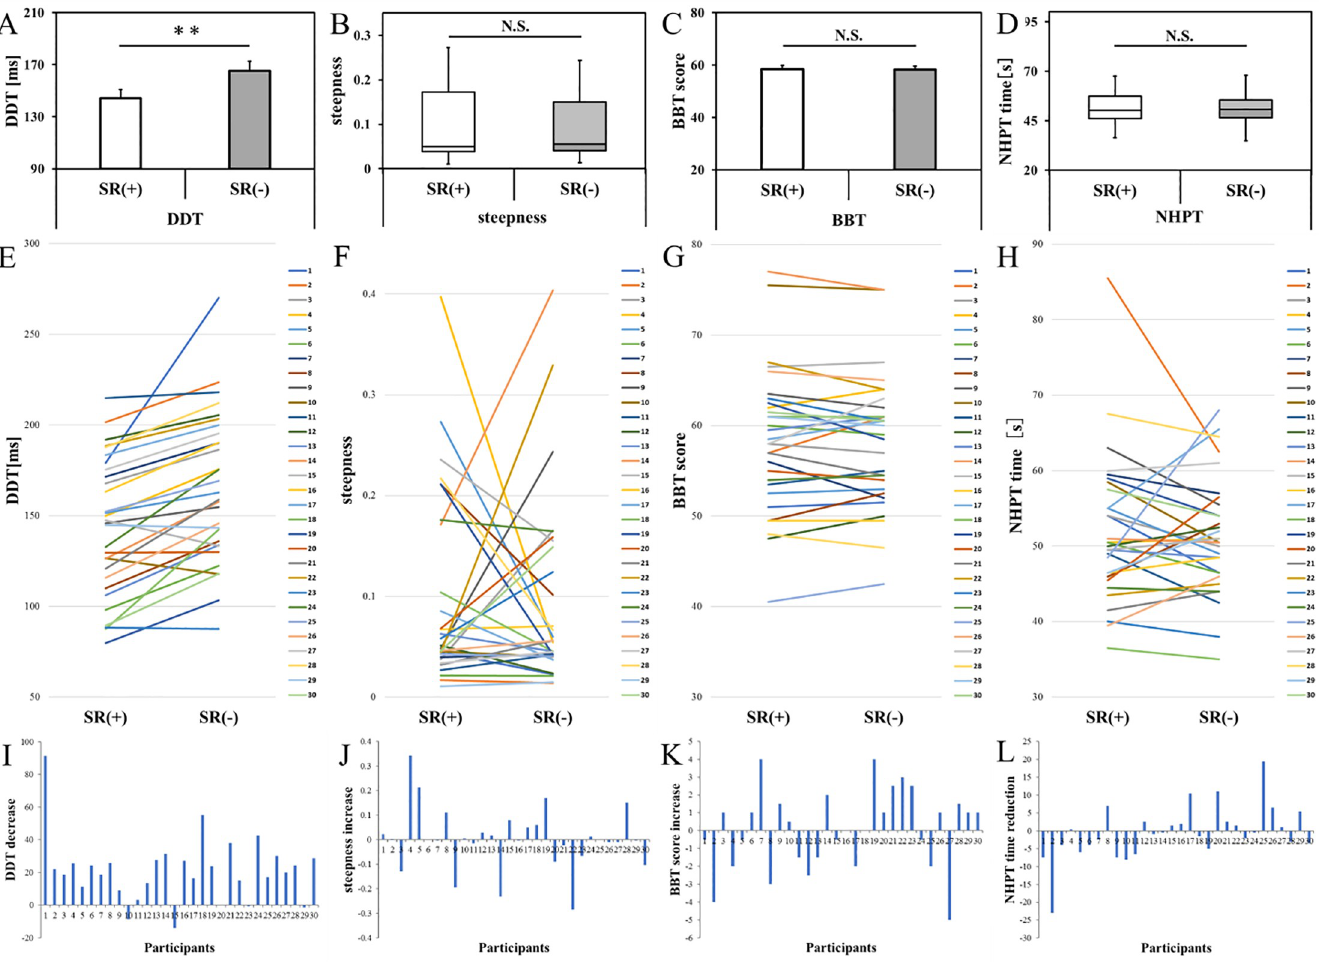
Fig 5. Comparison of the experimental task data in the stochastic resonance on- and off-conditions. DDT, delay detection threshold for the delayed visual feedback detection task; steepness, steepness of the delay detection probability curve in the delayed visual feedback detection task; BBT, box and block test; NHPT, nine hole peg test; SR (+), stochastic resonance on-condition; SR (-), stochastic resonance off-condition. �� P < 0.01; � P < 0.05. (A) Comparisons of the DDTs of the SR on- and off- conditions. Error bars represent the standard deviation of the mean. The DDT of the SR on-condition was significantly shortened compared with that of the off- condition (t = -5.840, P < 0.001). (B) Comparisons of the steepness of the SR on- and off-conditions. Lines represent the range of the minimum and maximum. Boxes represent the lower, median, and upper quartiles. There was no significant difference between the SR on- and off-conditions (z = -0.195, P = 0.845). (C) Comparison of the BBT scores of the SR on- and off-conditions. Error bars represent the standard deviation of the mean. There was no significant difference between the SR on- and off-conditions (t = 0.165, P = 0.870). (D) Comparison of the NHPT scores of the SR on- and off-conditions. The error bars represent the range of the minimum and maximum. The boxes represent the lower, median, and upper quartiles. There was no significant difference between the SR on- and off-conditions (z = -0.638, P = 0.524). Individual variability of the DDT (E), steepness (F), BBT scores (G), and NHPT scores (H) between the SR on- and off-conditions. Individual variation of the DDT (I), steepness (J), BBT scores (K), and NHPT scores (L) between the SR on- and